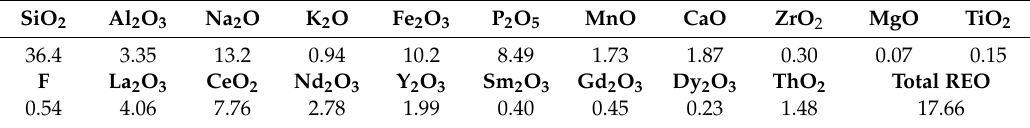
Table 1. X-ray fluoroscency-analysis of Kvanefjeld concentrate (in weights %). SiO 2 Al 2 O 3 Na 2 O